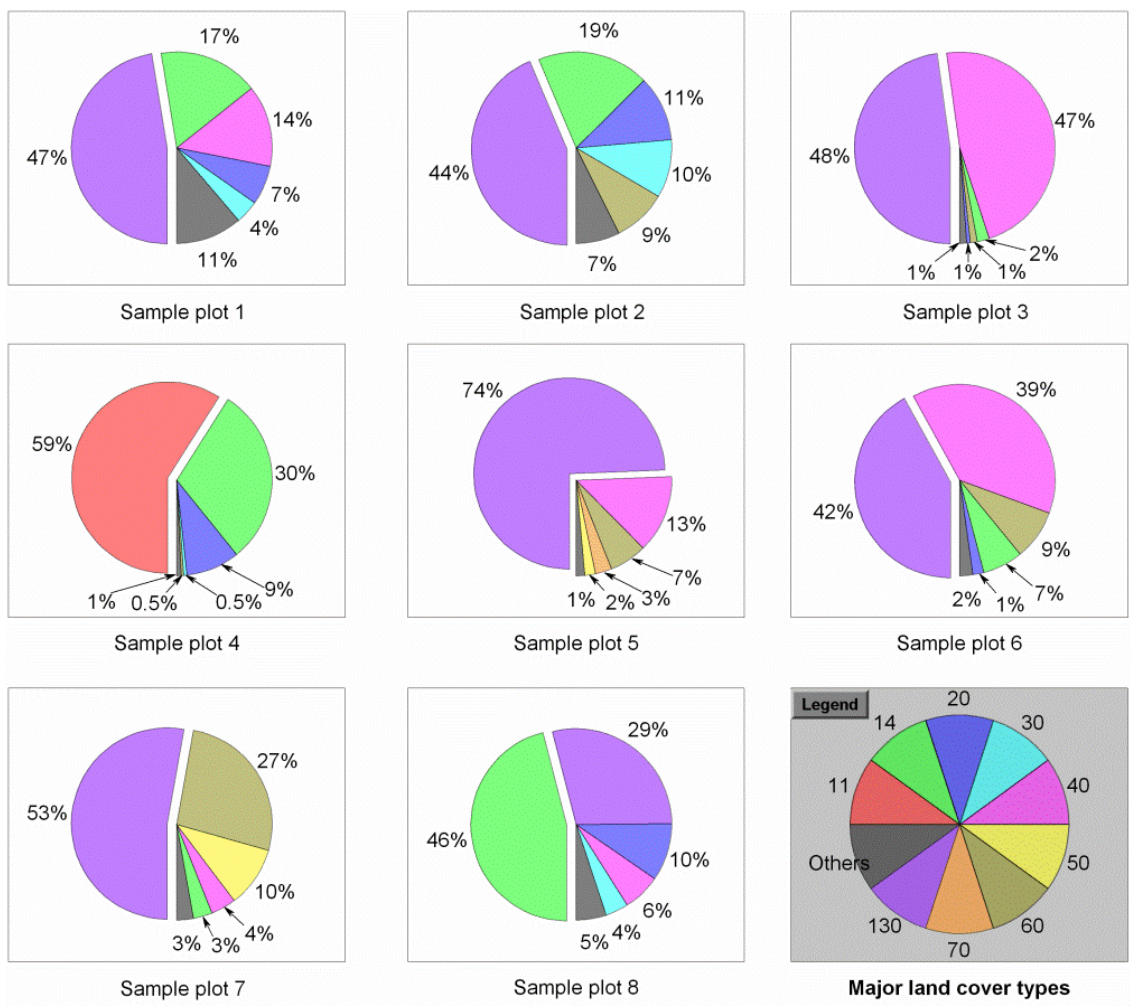
Figure 3. Area proportions of five major land use and land cover types within the eight sample plots in this study. The land cover data was extracted from the GlobCover 2009 provided by the European Space Agency (ESA). The figures in the legend plot refer to the land cover type codes of the global land cover